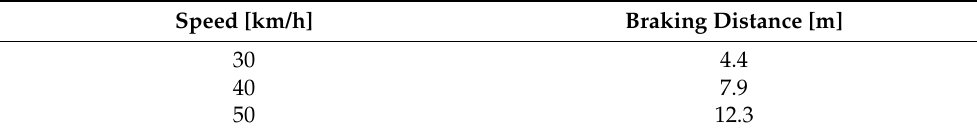
Table 1. Braking distances for the considered vehicle speeds, with a 0.8 g